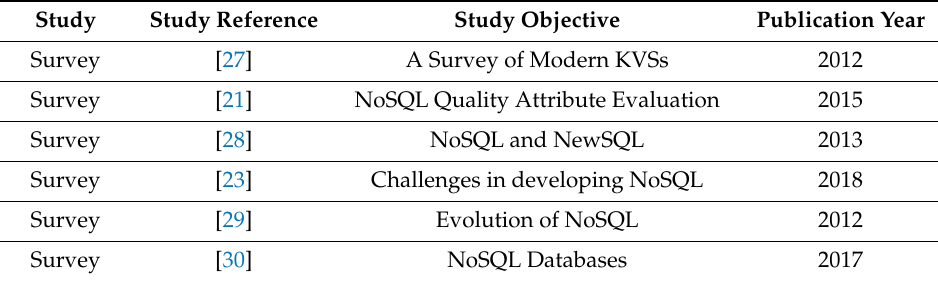
Table 1. Summary of related studies in non-relational Structured Query Language (NoSQL)